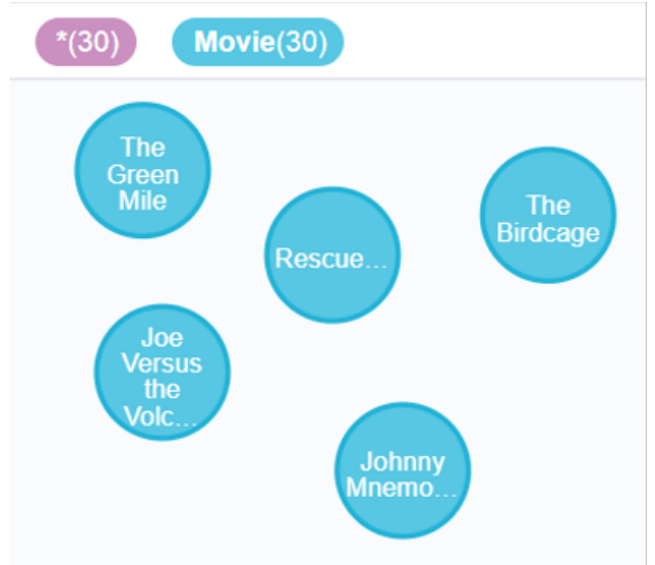
Figure 4. Example of movie entity.